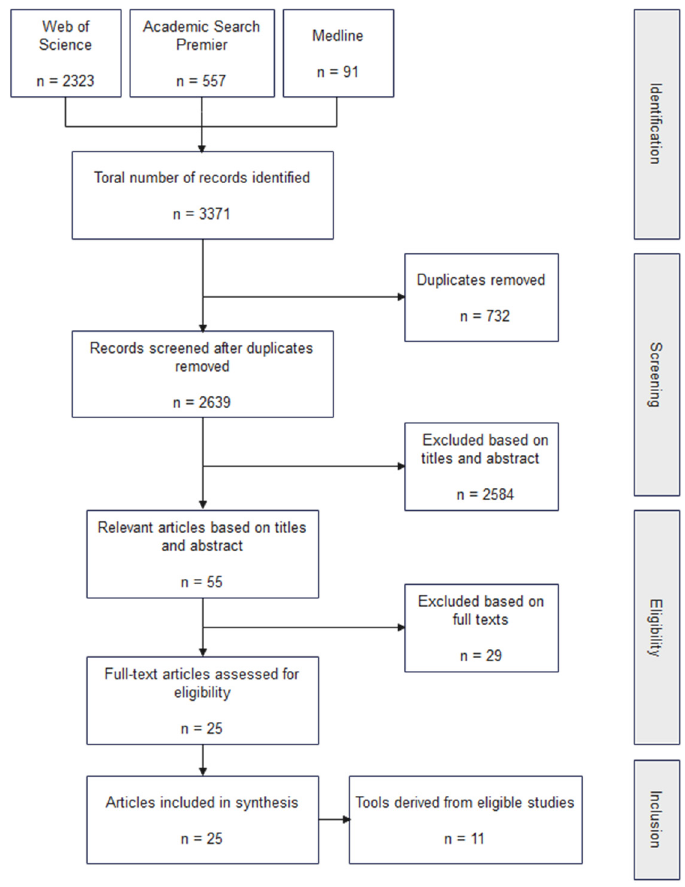
Figure 1. Flowchart of the literature review process.